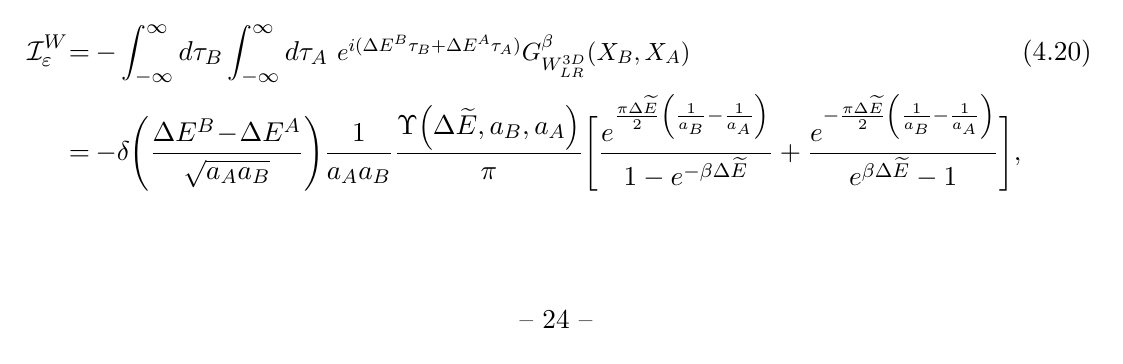
Figure 9 . In (1 + 1) dimensions the quantity ( ∂/∂σ ) anti-parallelly accelerating detectors with respect to the inverse temperature of the thermal bath σ for equal magnitude of proper accelerations α is σ independent, is α